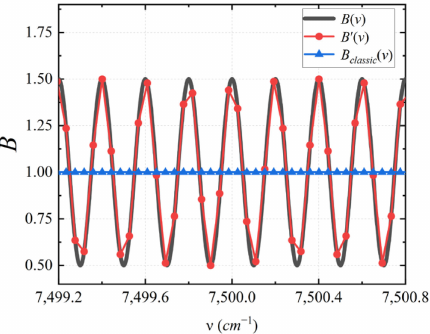
Figure 8. The result of the super-resolution spectrum when the input spectrum is a cosine function.